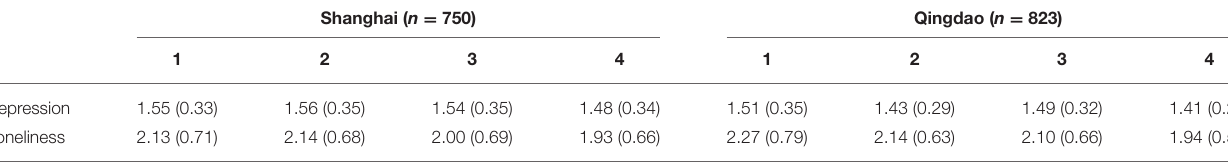
TABLE 5 | The scores on depression and loneliness in four clusters between two regions ( M , SD